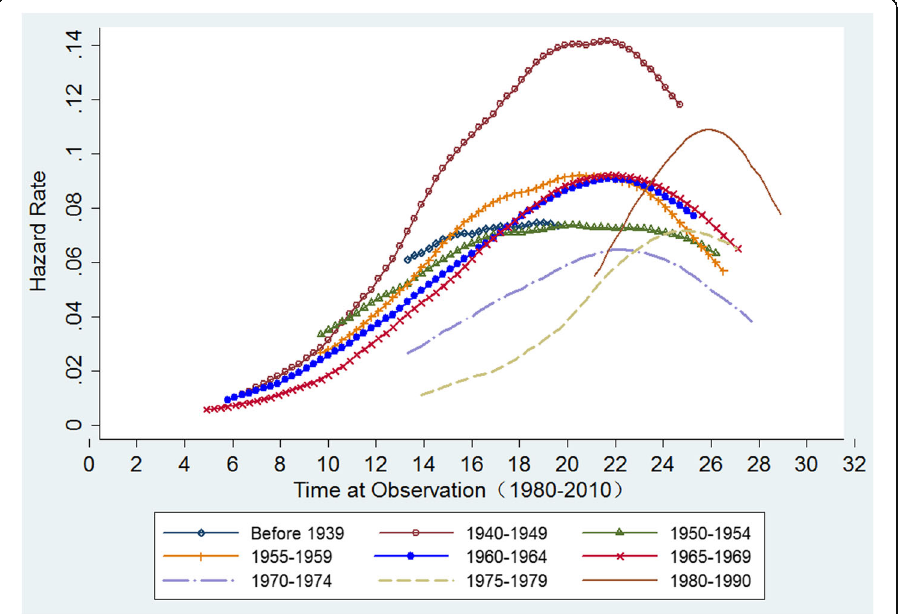
Fig. 3 Risk estimates for acquisition of the first housing property rights for each